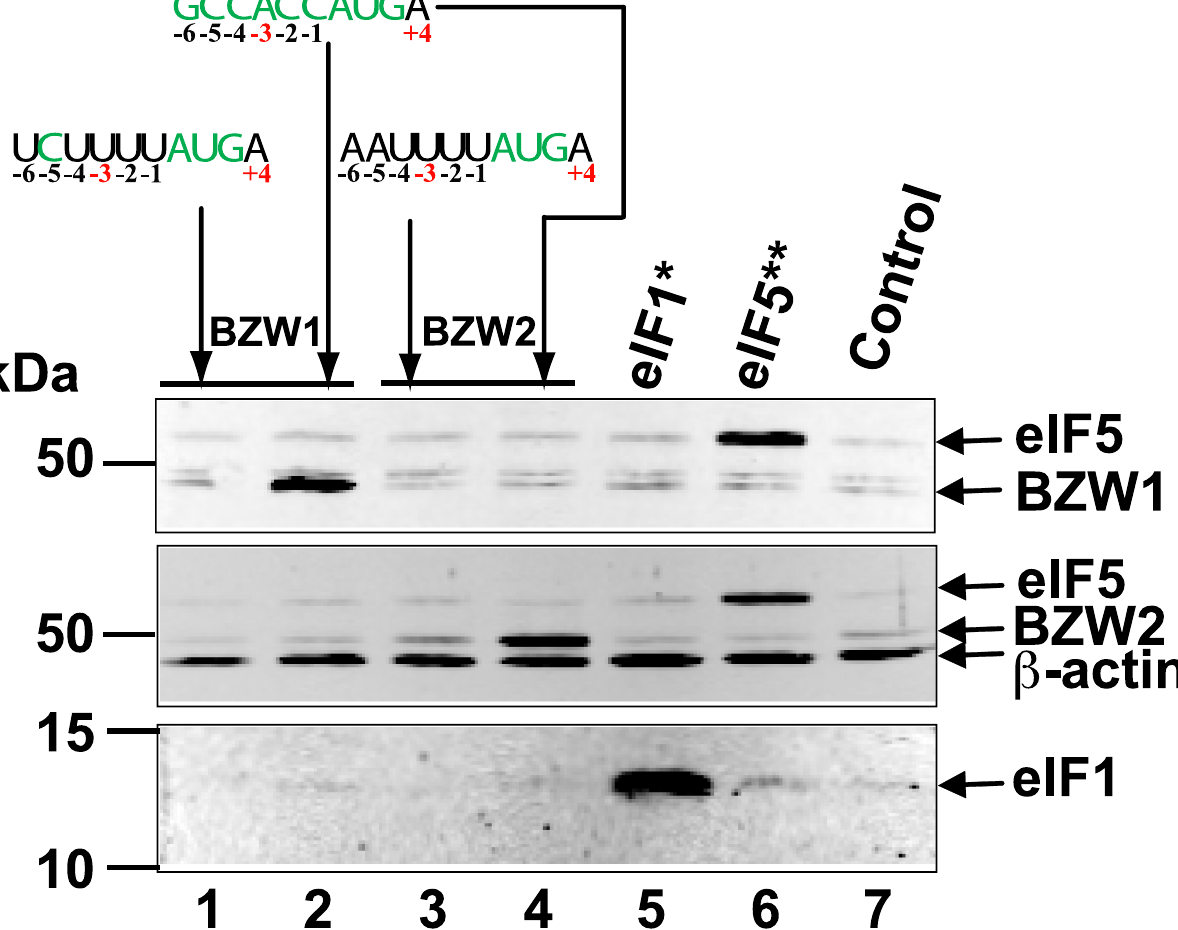
Fig 2. BZW1 and BZW2 are expressed poorly from their native initiation context. Anti-BZW immunoblots of lysates prepared from HEK-293T cells transfected with BZW-expressing plasmids with start codons in different contexts as indicated. BZW1 in native context (lane 1), BZW1 in optimal context (lane 2), BZW2 in native context (lane 3), BZW2 in optimal context (lane 4). Overexpression of deregulated stringency factors eIF1 and eIF5 are shown in lanes 5 and 6 respectively. The control lane shows lysates from cells transfected with pcDNA3.